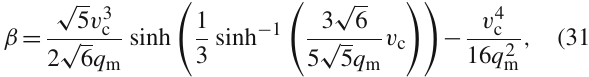
( T c1 = 0 . 0402936) and v c2 ≈ 4 . 45663 ( T c2 = 0 .